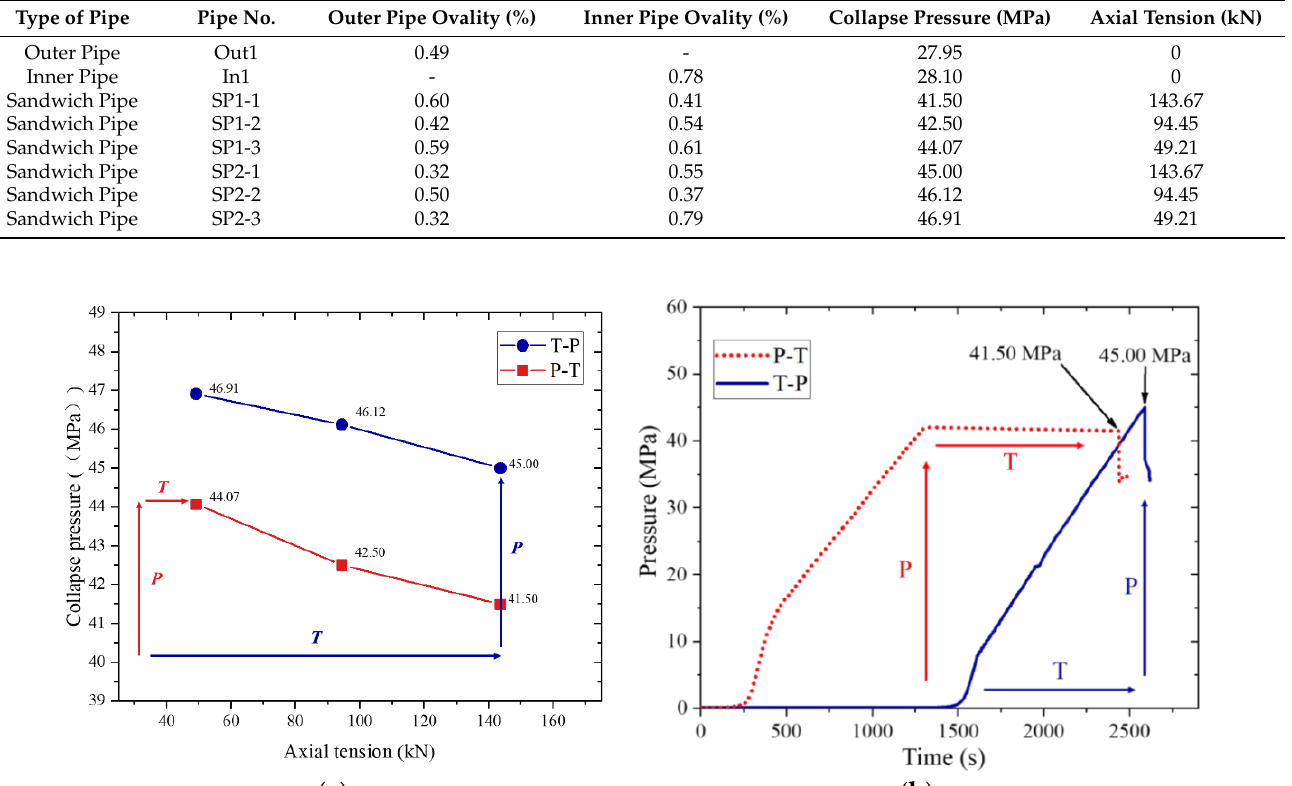
Table 4. Overview of ovality and collapse pressure of all tested specimens.